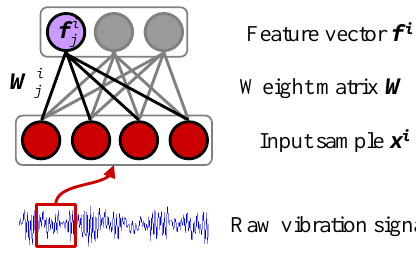
Figure 1. Architecture of sparse filtering.